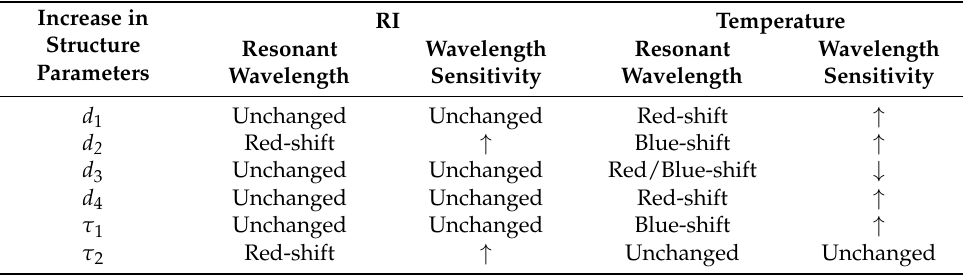
Figure 9. ( a ) The CL spectra of the core mode A when τ 1 is set as 40, 50, and 60 nm, and when the analyte RI increases from 1.35 to 1.40, respectively. ( b ) The CL spectra of the core mode B when τ 1 is set as 40, 50, and 60 nm, and when the temperature is chosen as 20, 40, and 60 °C, respectively. Table 1. Effects of the structural parameters of the proposed SPR-based PCF sensor on